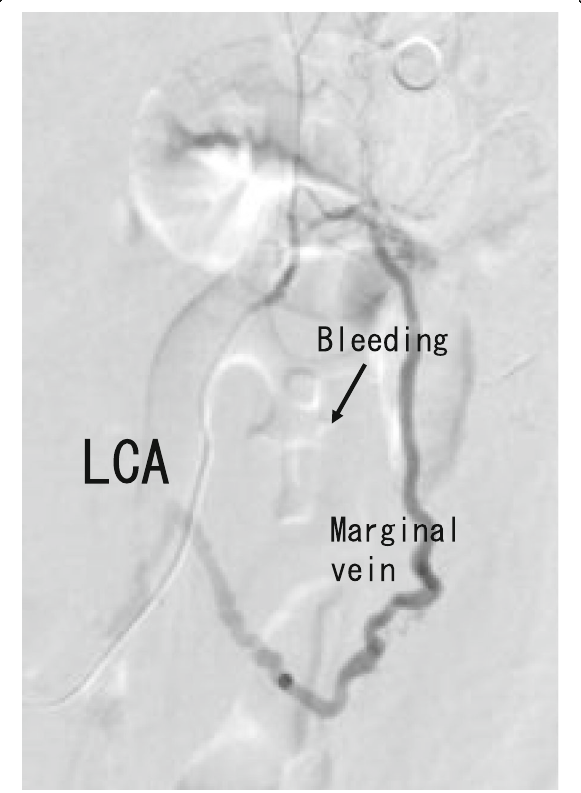
Fig. 6 Angiography showing an arteriovenous fistula in the descending colon